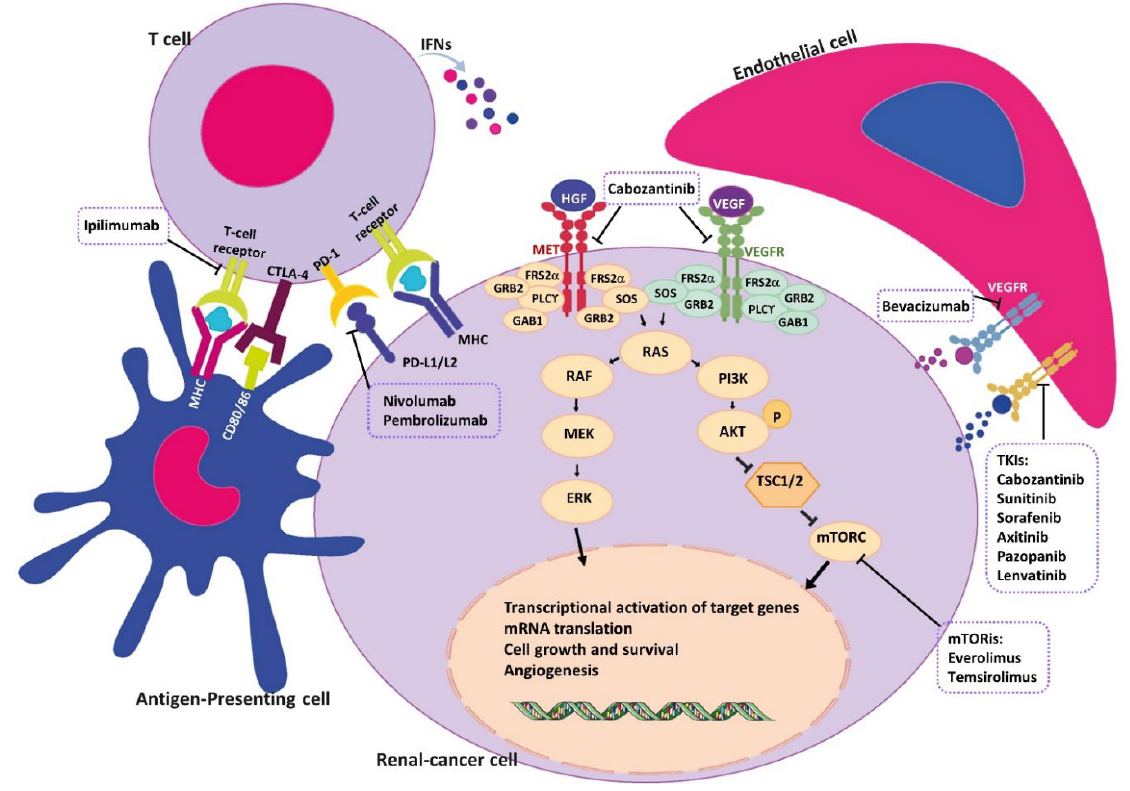
Figure 2. Schematic representation of major signaling pathways in the pathogenesis of nccRCC and therapeutic agents. VEGF and other involved growth factors secreted by renal cancer cells stimulate angiogenesis in the neighboring vascular endothelial cells. In renal cancer cells, growth factors (such as HGF and VEGF) binding to the TKRs (such as VEGFR and c-Met) induce several signaling cascades that lead to proliferation, invasion, survival, and angiogenesis in renal tumor cells. The increased activation of the mTOR pathway leads to the activation of cell growth, survival, metabolism, migration, and angiogenesis of tumor cells. Bidirectional cross-talk between endothelial and renal cancer cells leads to the progression of RCC. Antigen-presenting cells present tumor antigens to a naïve T cell, and after a set of cellular events, the T cell is activated. PD-1 is expressed on activated T cells and, upon binding to its ligand PD-L1/L2 on renal cancer cells, resulted in T cell exhaustion. This binding negatively regulates T cell activity and leads to evading the host immune system. Ab-